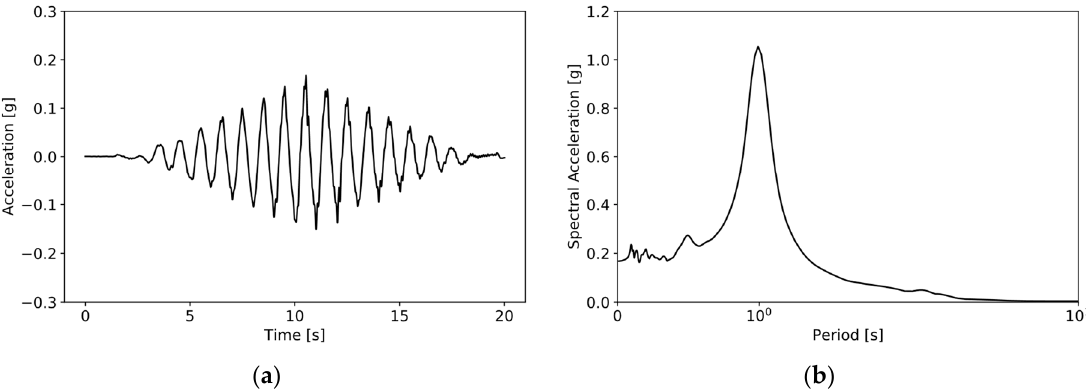
Polytechnic Institute, RPI (Kutter et al. (2018) [33]) ( b ) 5% damped spectral acceleration at the base of